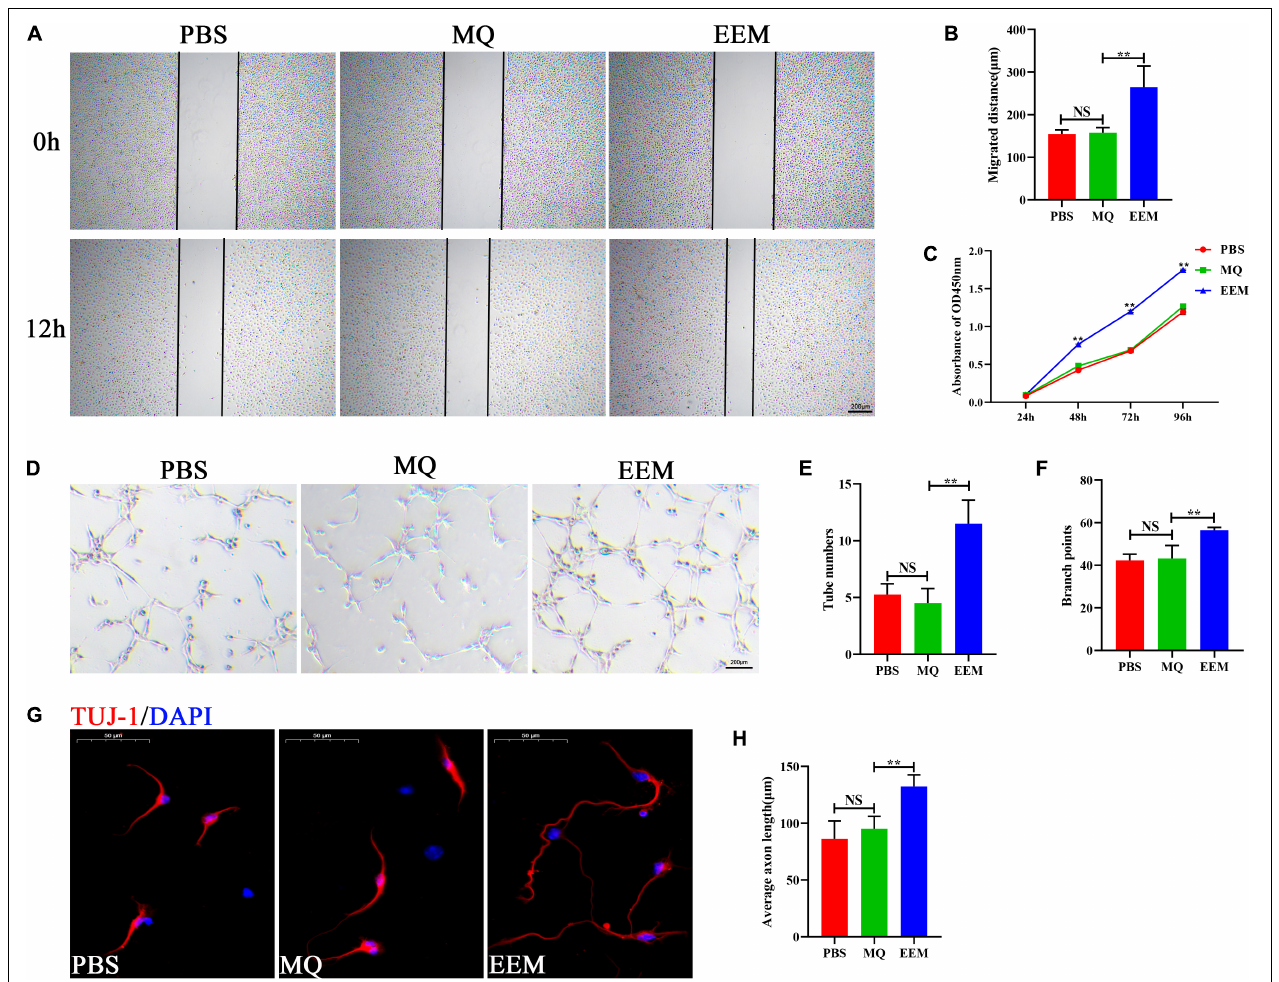
FIGURE 3 | EEM promote angiogenic activity and axon growth in vitro . (A) Representative images of the horizontal migration of HUVECs in the EEM, MQ, and PBS treatment groups, as shown by wound healing experiments. (B) Quantification of the migration distance shown in (A) [ F (2, 9) = 17.75, p < 0.05. Tukey’s post hoc test. PBS vs. MQ, p = 0.98; MQ vs. EEM, p < 0.01; n = 4 biological replicates for each group]. (C) Analysis of HUVECs proliferation by CCK-8 [ F (2, 6) = 1,346, p < 0.01. Tukey’s post hoc test. MQ vs. EEM (24 h), p = 0.5071; MQ vs. EEM (48 h), p < 0.01; MQ vs. EEM (72 h), p < 0.01; MQ vs. EEM (96 h), p < 0.01; n = 3 biological replicates for each group]. (D) Representative images of HUVEC canaliculization in the EEM, MQ, and PBS treatment groups. Scale bar: 200 µ m. (E) Quantification of tube numbers of (D) [ F (2, 9) = 25.63, p < 0.01. Tukey’s post hoc test. PBS vs. MQ, p = 0.77; MQ vs. EEM, p < 0.01; n = 4 biological replicates for each group]. (F) Quantification of branch points of (D) [ F (2, 9) = 15.98, p < 0.01. Tukey’s post hoc test. PBS vs. MQ, p = 0.93; MQ vs. EEM, p < 0.01; n = 4 biological replicates for each group]. (G) Representative immunofluorescence images of TUJ1 (red) in the EEM, MQ, and PBS treatment groups. Scale bar: 50 µ